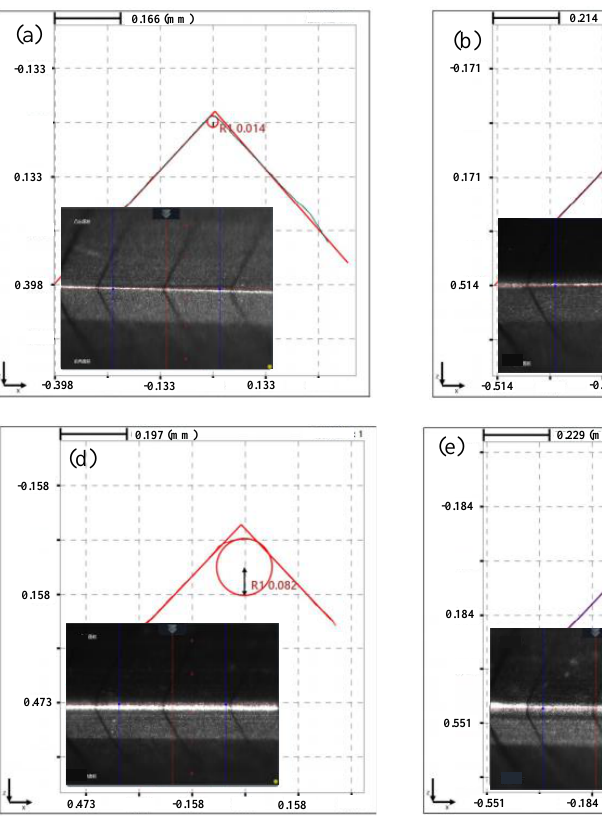
Figure 8. Edge shape diagram under different polishing angles for 5 min: ( a ) before preparation, ( b ) α = − 20 ◦ , ( c ) α = − 10 ◦ , ( d ) α = − 0 ◦ , ( e ) α = 10 ◦ , ( f ) α = 20 ◦ .